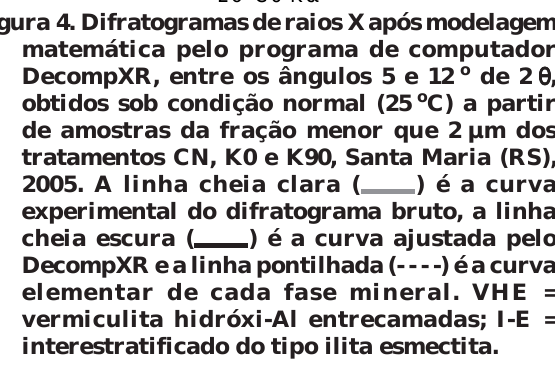
Figura 3. Difratogramas de raios X brutos (a) entre os ângulos 2 e 35 o de 2 θθθθθ , obtidos sob condição normal (25 o C) a partir de amostras da fração menor que 2 µm, 2–5 µm e menor que 0,2 µm do CN; (b) entre os ângulos 2 e 15 o de 2 θθθθθ , correspondendo as reflexões 001 , obtidos sob condição normal (25 o C) a partir de amostras da fração menor que 2 µm dos tratamentos CN, K0 e